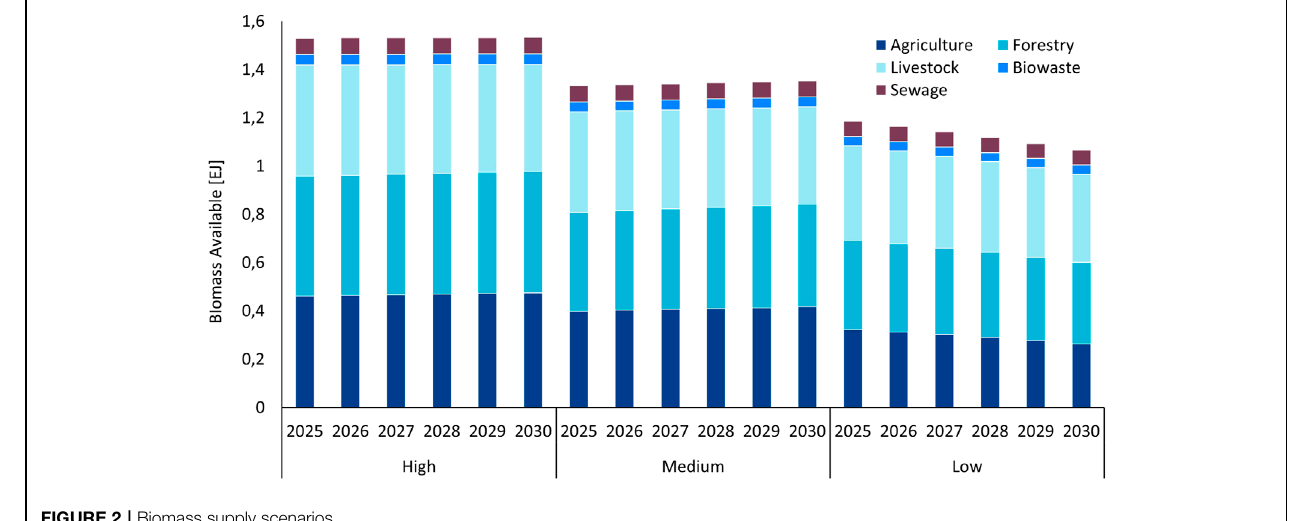
FIGURE 2 | Biomass supply scenarios.